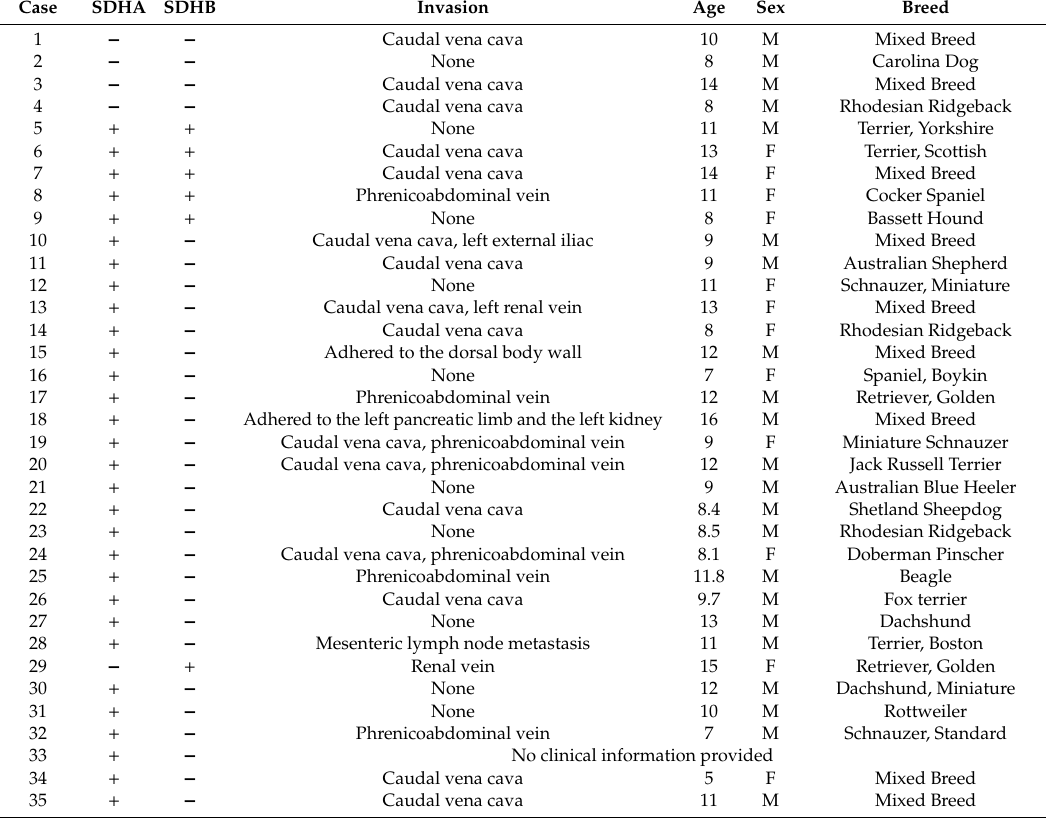
Table 1. Immunohistochemical findings and clinical information for all